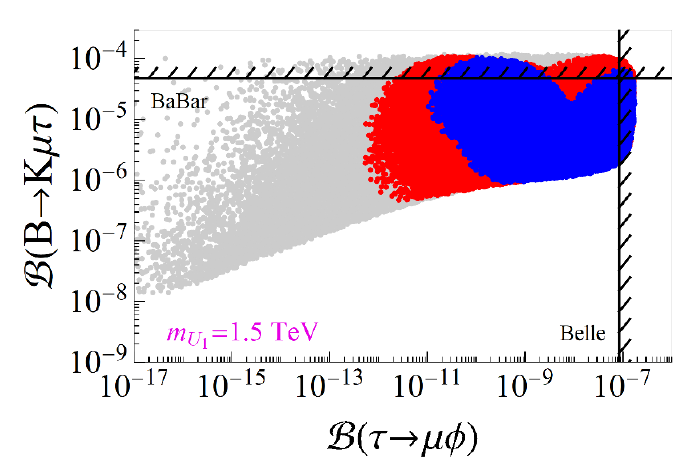
Figure 9 . B ( B ! K(cid:22)(cid:28) ) is plotted against B ( (cid:28) ! (cid:22)(cid:30) ) for the U 1 model. Color code is the same as in (cid:12)gure 7. Current bounds on these two decays, as respectively established by BaBar [99] and by Belle [93], are also